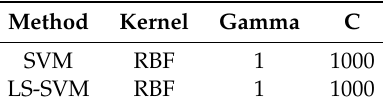
Table 5. Selected parameters.